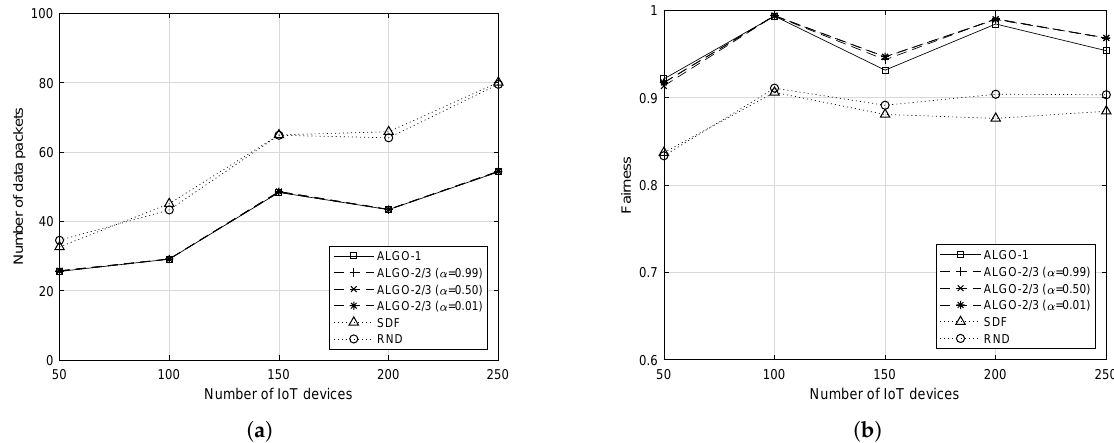
Figure 6. Average fairness performance with respect to different number of IoT devices when v = 20. ( a ) Average maximum load; ( b ) Fairness performance.